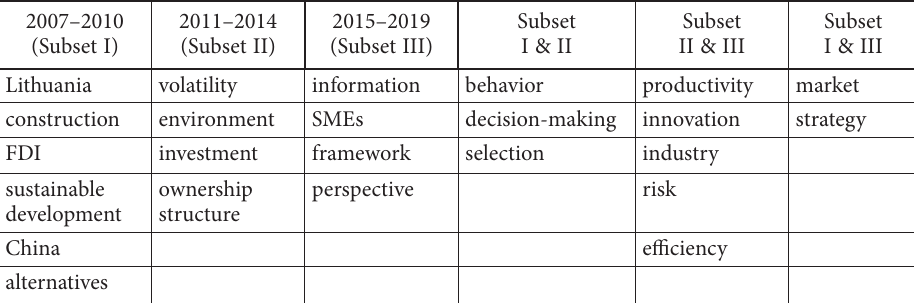
Table 4. Keywords Change in three different